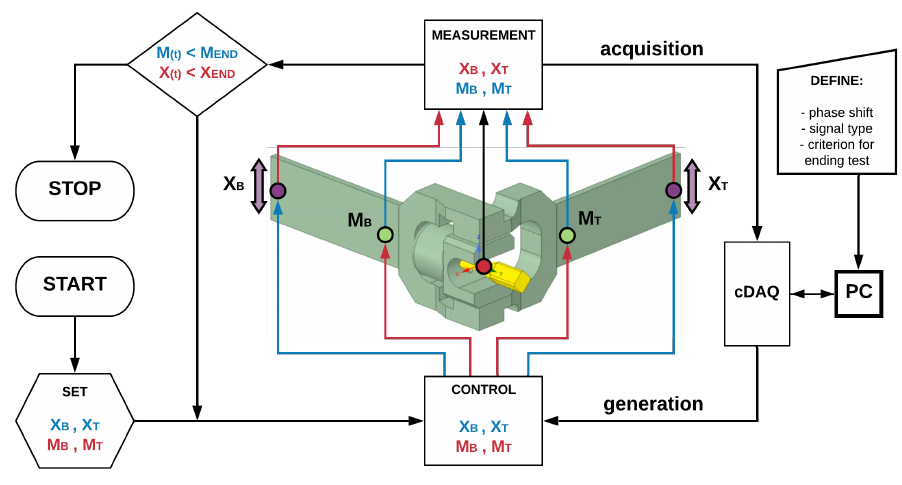
Figure 3. Fatigue machine control and conditioning